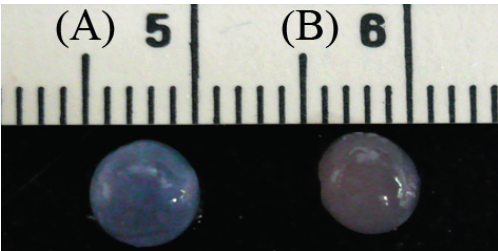
Figure 7. The morphology of PRP-SF-MSCs-alginate complex with ( A ) 0% PRP and ( B ) 20% or 50%. Scale unit: 1